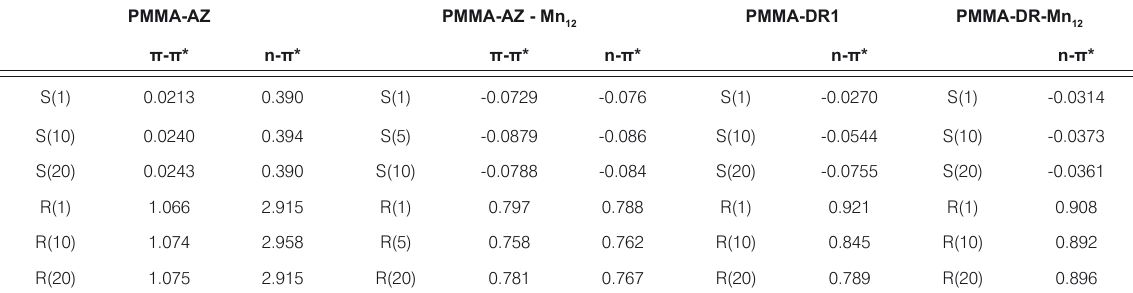
Table 1. Photoanisotropy parameters S and R for cis solutes in PMMA film (number of photoisomerization cycles in